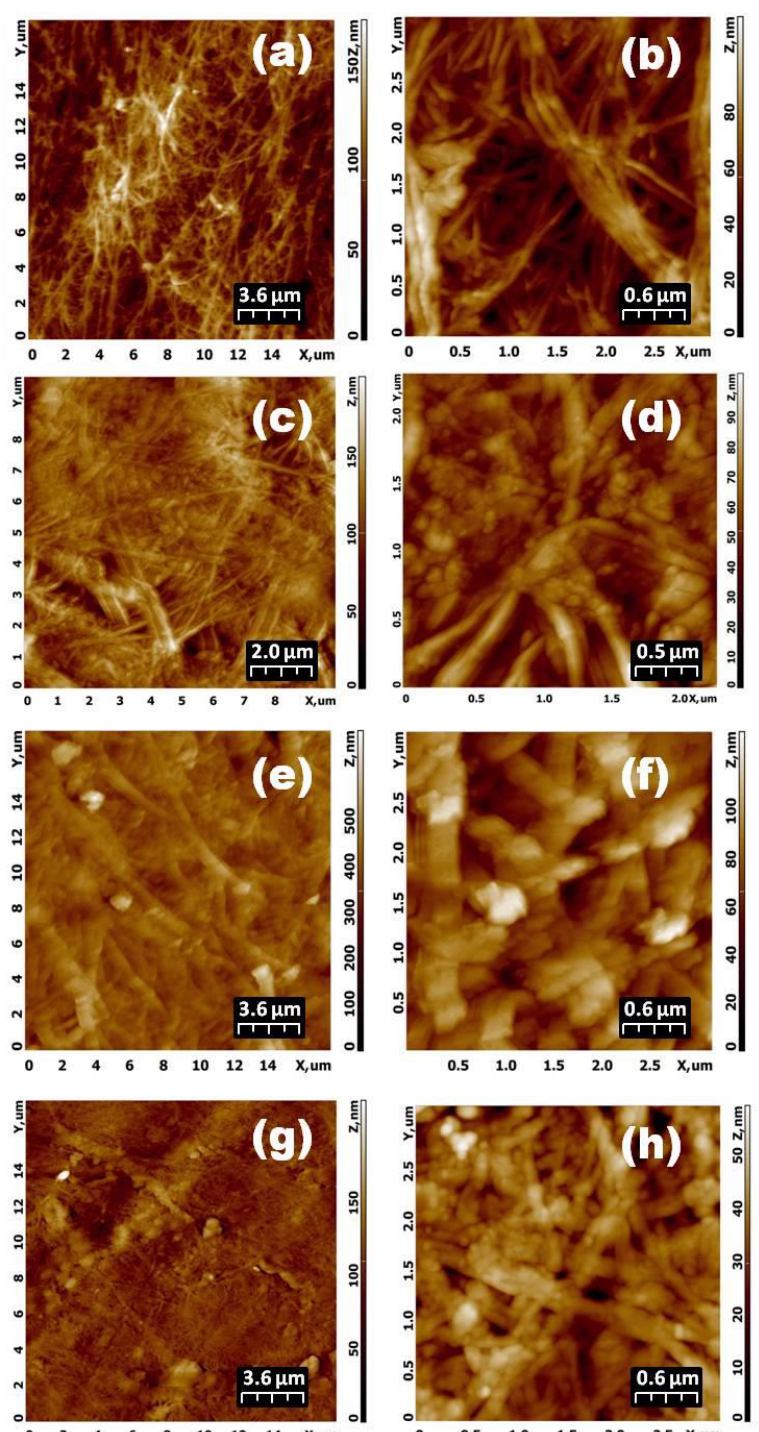
Figure 7. Variation of AFM topologies of the supercritically dried samples of BC: native nano-gel film ( a ): 18 µm × 18 µm, ( b ): 3.2 µm × 3.2 µm, and samples treated by CBHSc for 120 min ( c ): 10 µm × 10 µm, ( d ): 2.5 µm × 2.5 µm, 240 min ( e ): 18 µm × 18 µm, ( f ): 3.2 µm × 3.2 µm and 1440 min ( g ): 18 µm × 18 µm, ( h ): 3.2 µm × 3.2 µm, respectively.